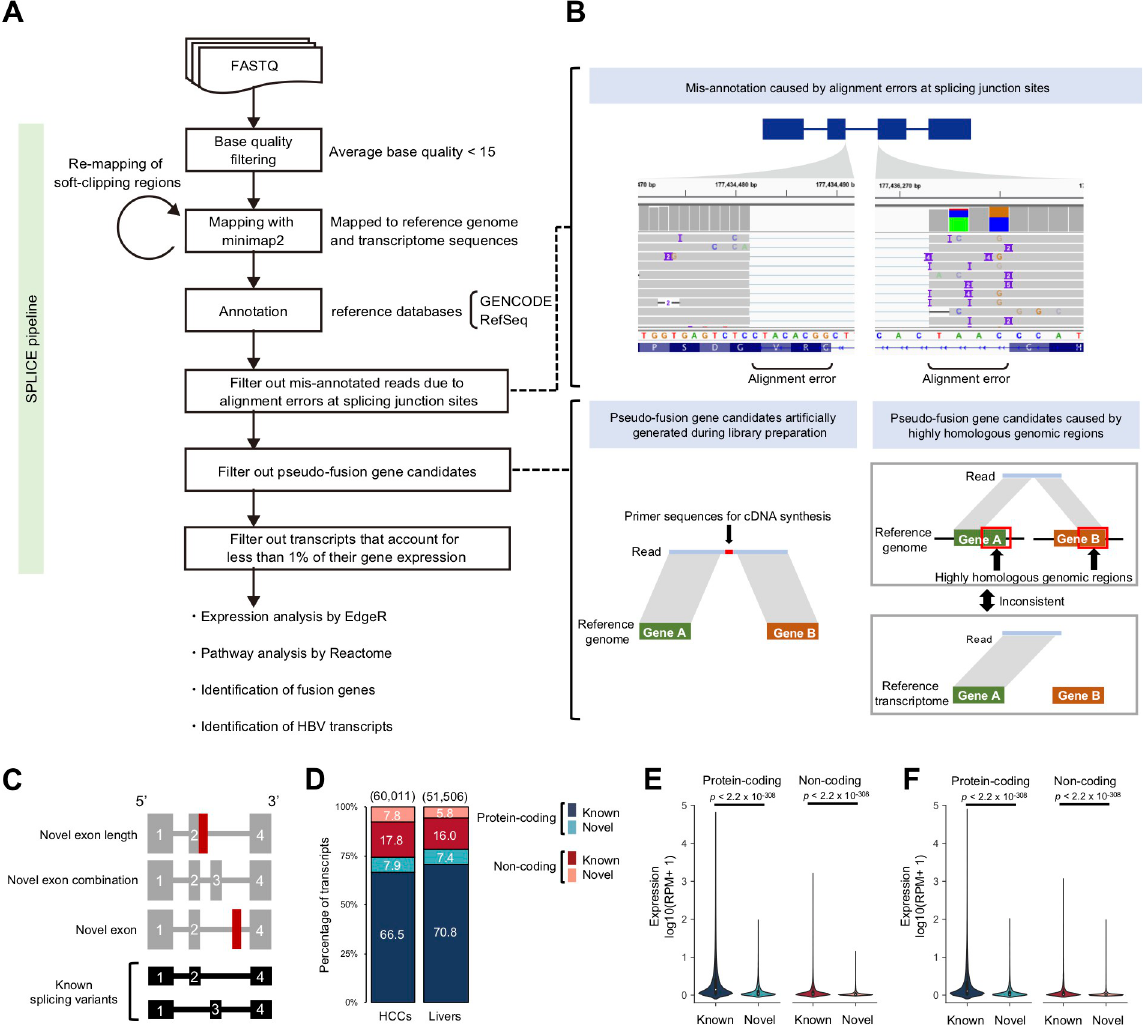
Fig 1. Overview of the SPLICE pipeline and HCC sequencing library. ( A ) Workflow of the SPLICE pipeline and data analysis of this study. Reads with an average base quality score < 15 were removed from the input FASTQ files. The read sequences were mapped to the reference genome, reference transcriptome sequences, and remapped soft-clipped regions ( ≧ 60 bp). Candidates corresponding to the error patterns or low-frequency transcripts were removed. The final data were used for the subsequent data analyses. ( B ) Error patterns in cDNA-seq using MinION. Alignment errors caused by sequencing errors, artificial chimeras, and mapping errors of highly homologous genes can result in errors. ( C ) Classification of patterns of novel transcripts. "Novel exon length" contains known exons with different lengths from the reference database. "Novel exon combination" has a different exon combination from the reference database. “Novel exon” contains exons expressed from regions that are not overlapped with known exons. ( D ) Composition of the transcripts. The stacked bar chart shows the distribution (%) of detected transcripts by transcript type. The total number of transcripts is shown above the bars. ( E,F ) Comparison of expression levels of known and novel transcripts. Transcript abundance was measured in reads per million reads (RPM), and log10 converted values for RPM+1 are shown in the violin plot. P -values were calculated by the Wilcoxon rank-sum test. ( E ) Comparison in HCC samples. ( F ) Comparison in non-cancerous liver